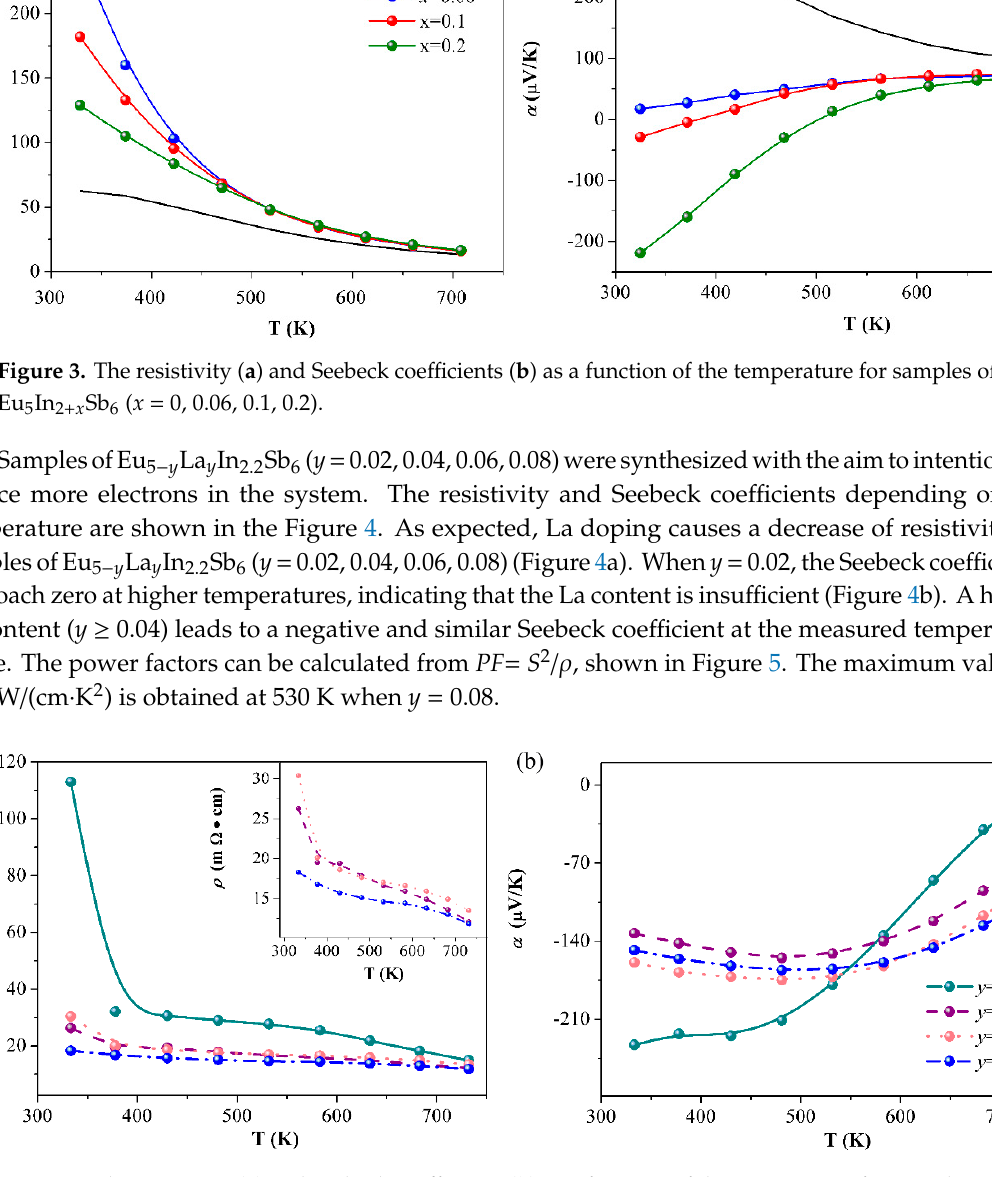
Figure 4. The resistivity ( a ) and Seebeck coefficients ( b ) as a function of the temperature for samples of Eu 5 − y La y In 2.2 Sb 6 ( y = 0.02, 0.04, 0.06, 0.08).